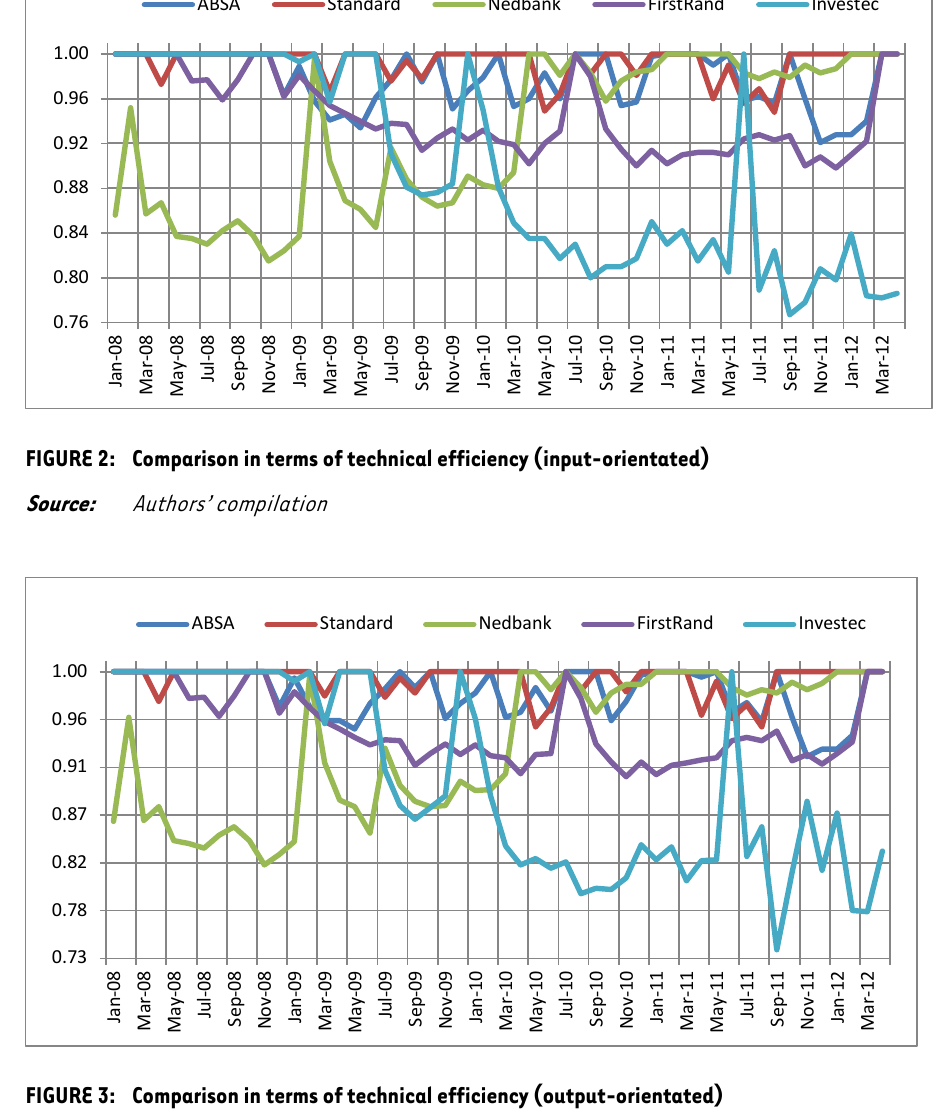
FIGURE 3: Comparison in terms of technical efficiency (output-orientated)